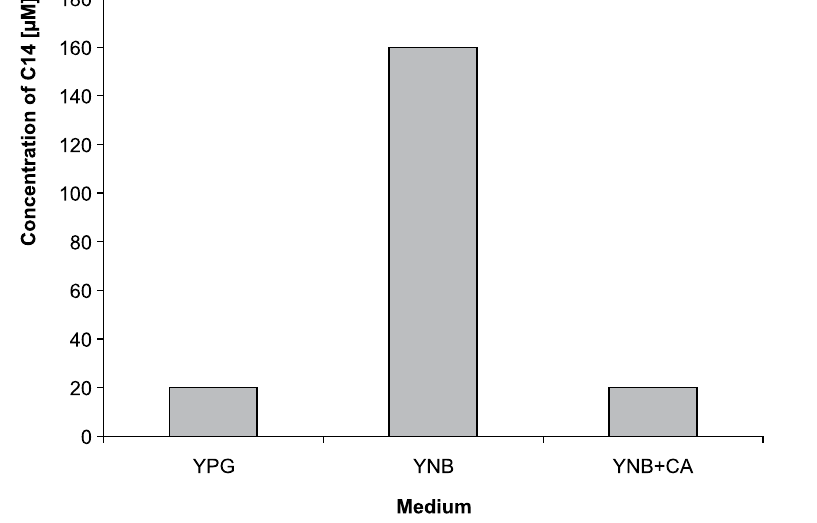
Fig. 1. Growth of T.cutaneum on the medium YPG,YNB and YNB+Casamino acids at the presence of C14